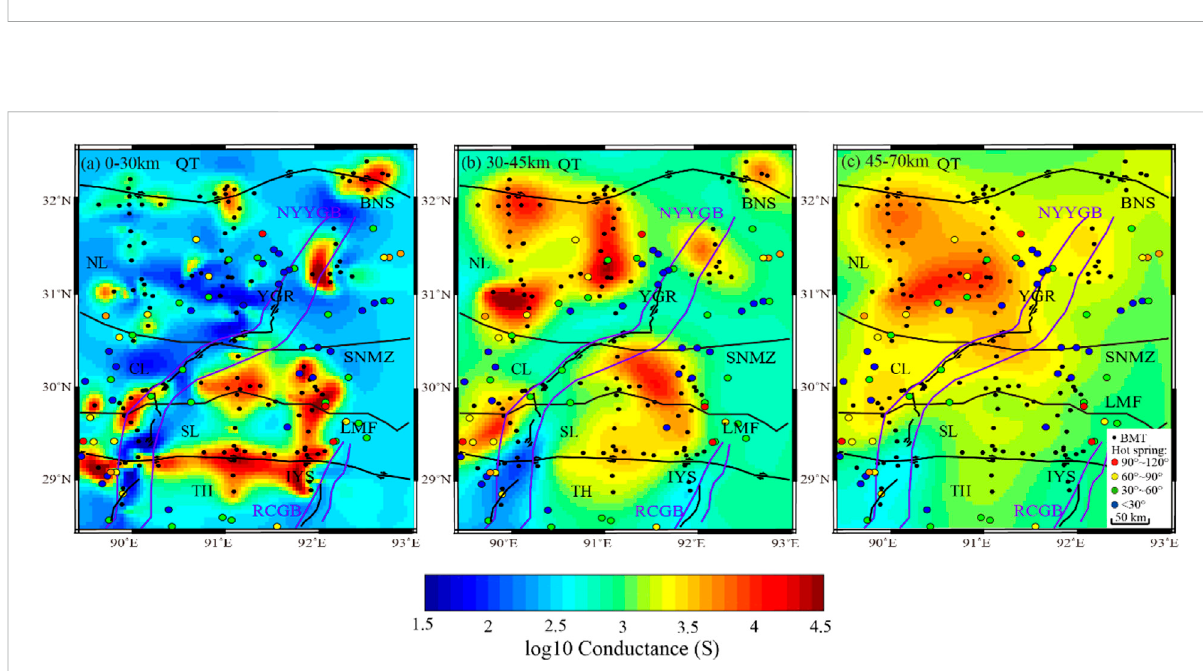
FIGURE 12 A map showing the distribution of conductance (A) Horizontal distribution of conductance at depths of 0 – 30 km. (B) Horizontal distribution of conductance at depths of 30 – 45 km. (C) Horizontal distribution of conductance at depths of 45 – 70 km.